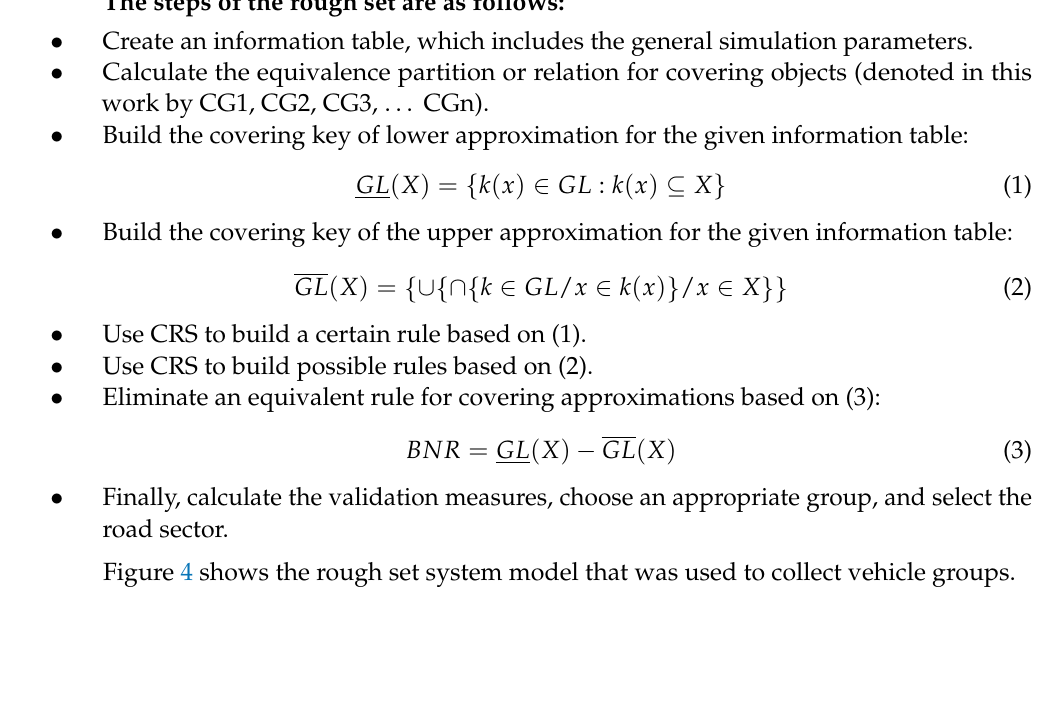
Figure 3. Rough sets and set approximation.